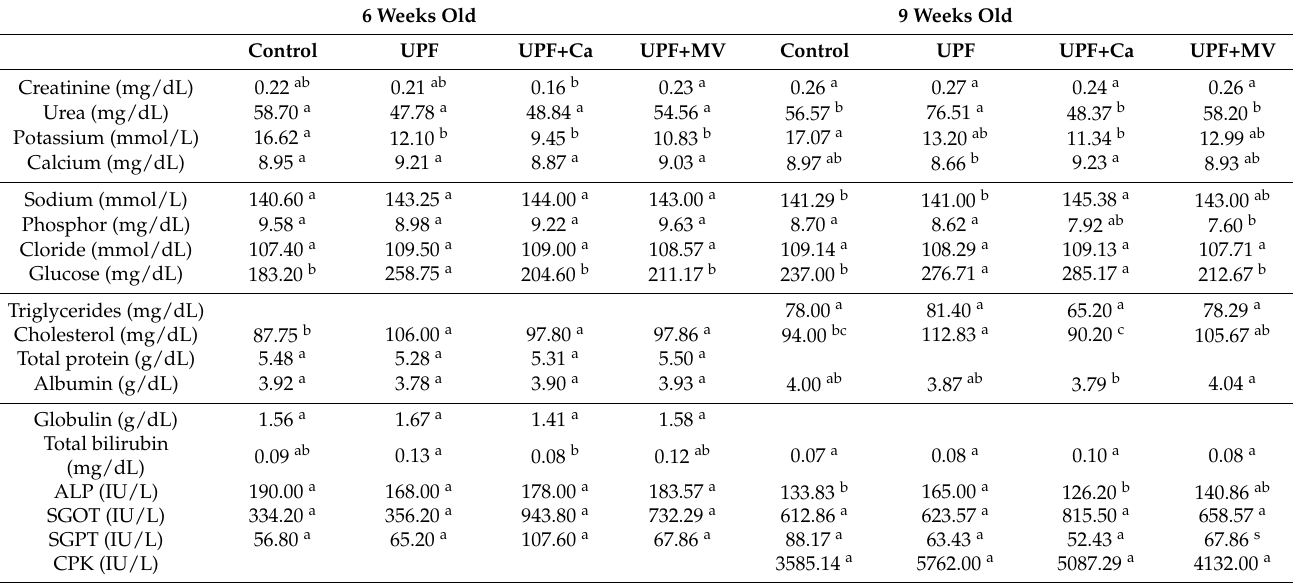
Total protein (g/dL) 5.48 a